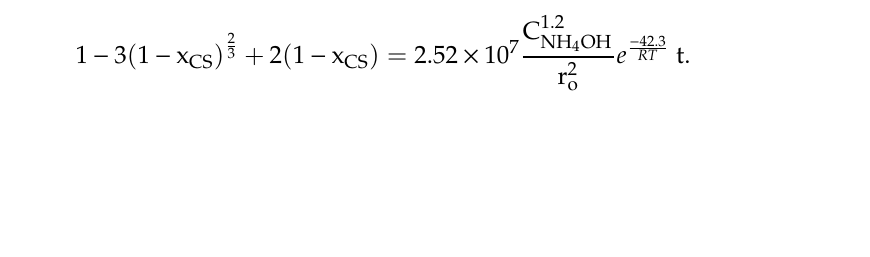
ammonia Table 1. Temperature-dependent and apparent rate constant values for converter slag leaching in ammonia system.